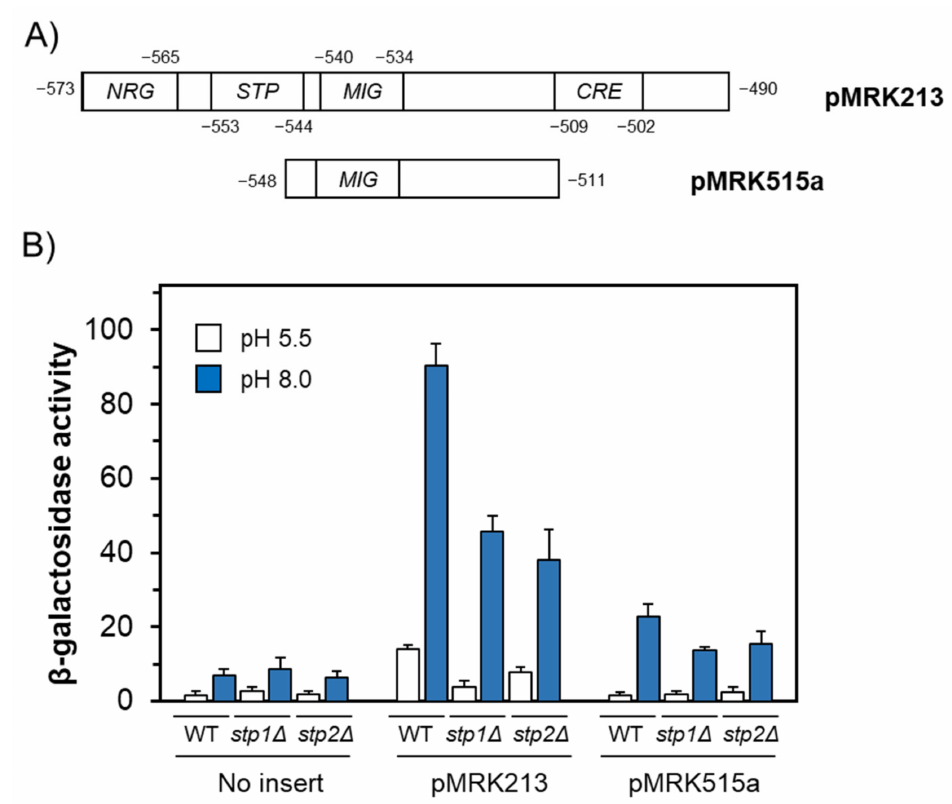
Figure 3. Removal of the putative Stp1/2 site drastically decreases expression from a lacZ reporter. ( A ) Schematic depiction of the constructs used. ( B ) Strain BY4741 (WT) and its isogenic stp1 and stp2 derivatives were transformed with the indicated constructs or the empty pSLF ∆ -178K vector (“No insert”). Cells were treated as indicated in Materials and Methods and β -galactosidase activity was determined after 1 h of induction. Data are mean ± SEM from 4 to 6 independent